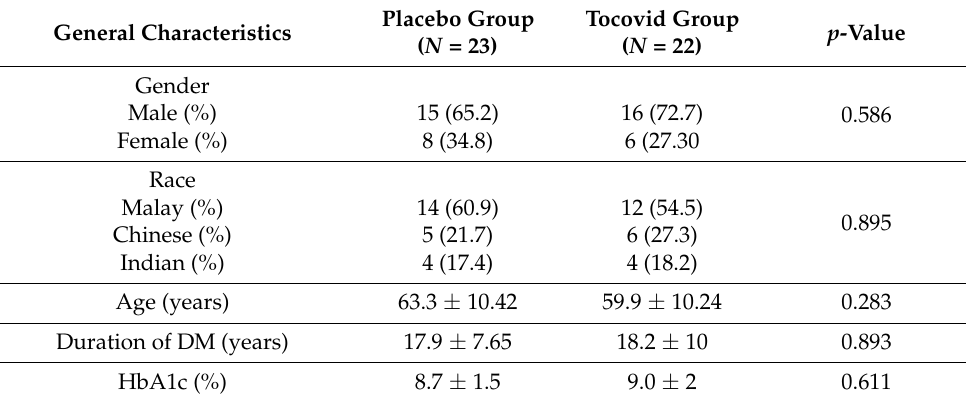
Table 7. General characteristics and blood chemistry between placebo and Tocovid